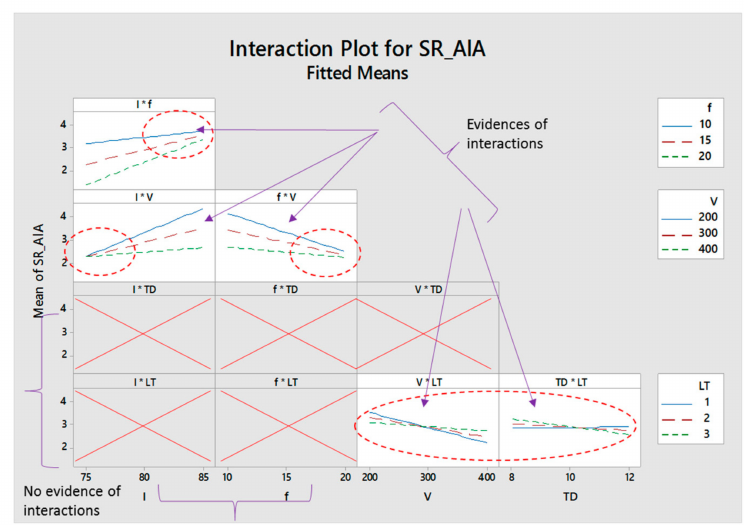
Figure 6. Interaction plot for nickel alloy.